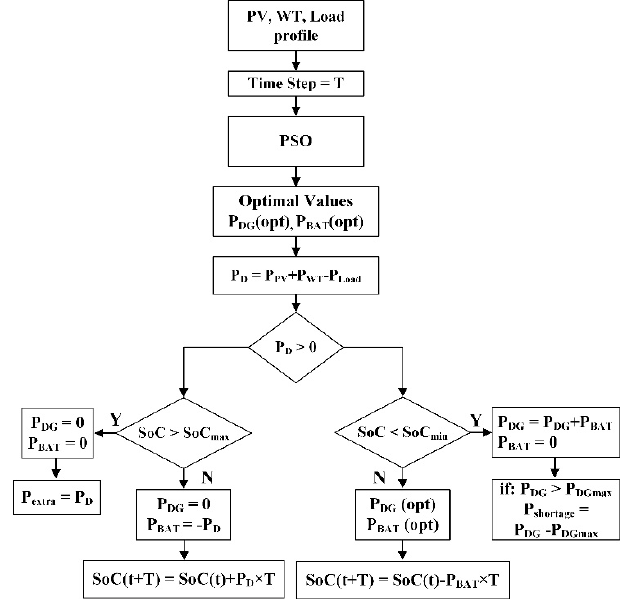
Figure 5. Control strategy of individual MGs.